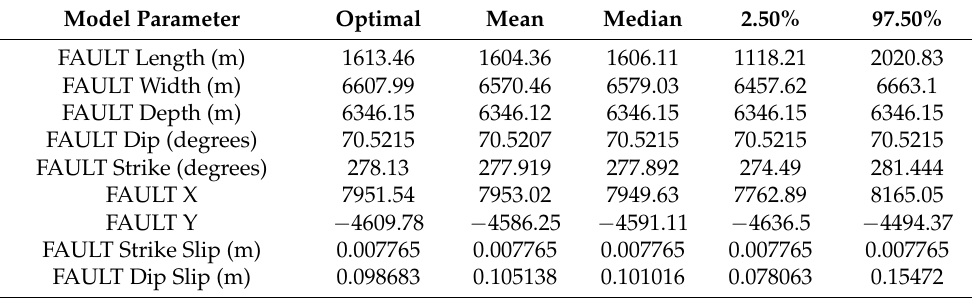
Table 1. Results of GBIS fault